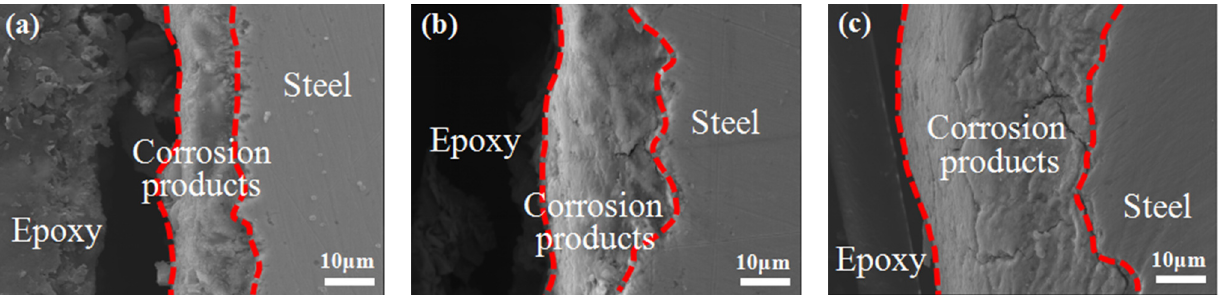
Figure 5. Cross-sectional morphology of corrosion products after different time corrosion: ( a ) 72 h; ( b ) 288 h; ( c ) 600